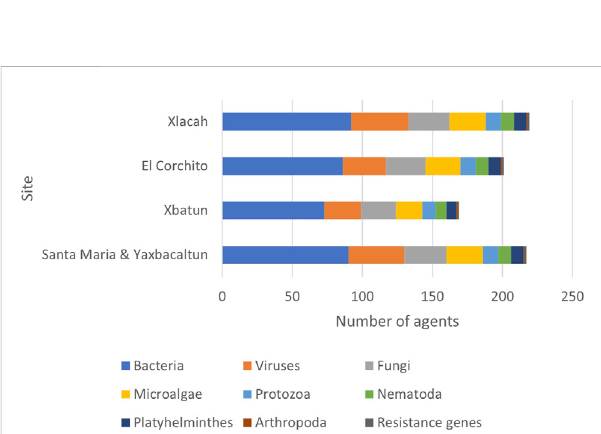
FIGURE 3 Etiological agents and resistence genes included in the microarray and detected in cenotes by classi fi cation.